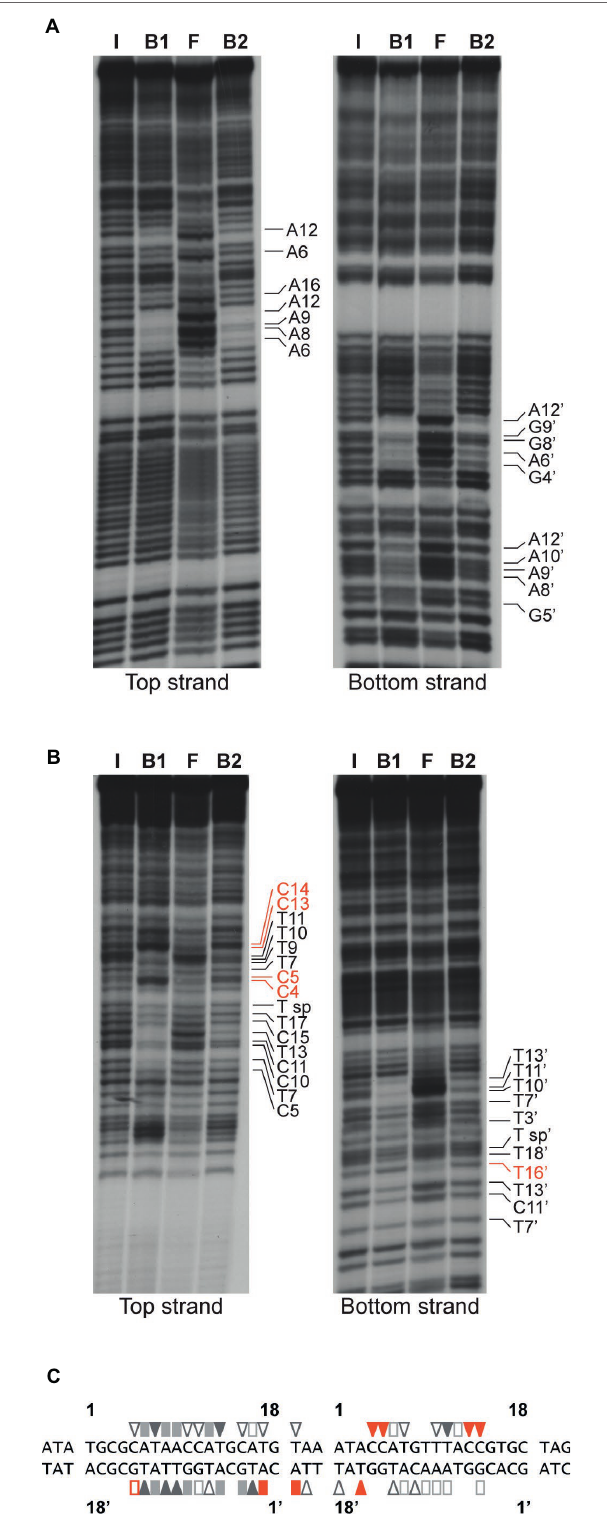
FIGURE 7 | Missing contact probing with ArgR binding to the lrp control region. (A) Depurination (citrate) and (B) depyrimidination (hydrazine).